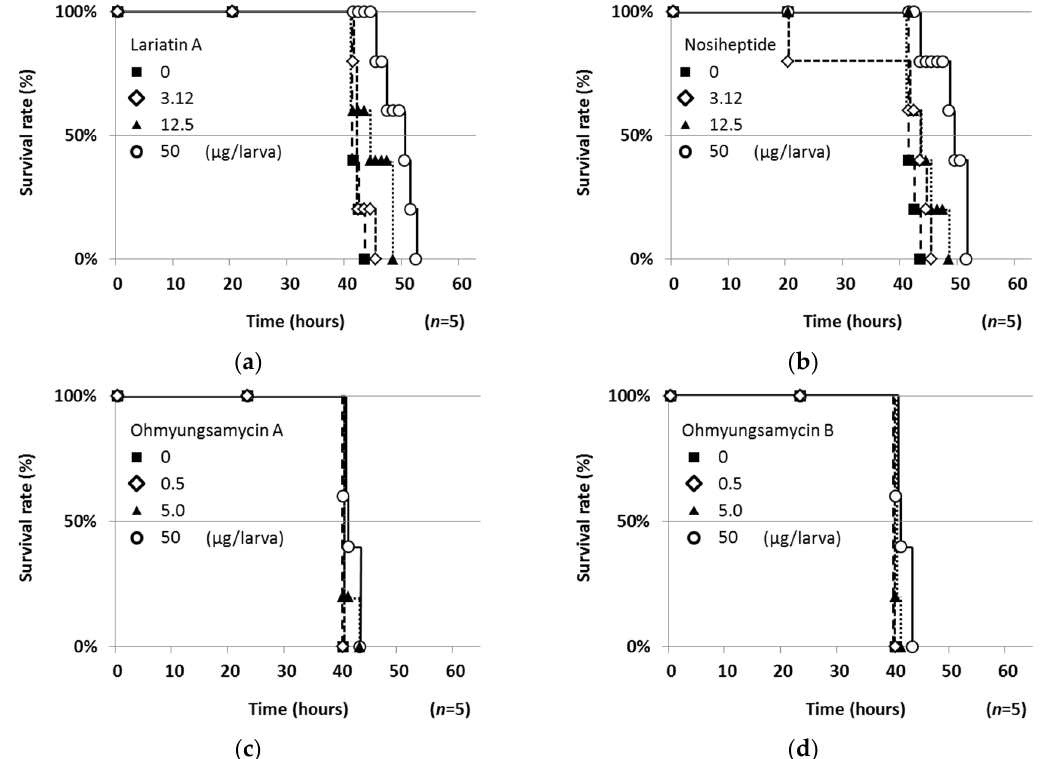
Figure 6. Therapeutic effects of microbial anti-NTM compounds in the silkworm infection assay with My. abscessus . ( a ) Lariatin A ( 1 ), ( b ) nosiheptide ( 2 ), ( c ) ohmyungsamycin A ( 3 ) and ( d ) ohmyungsamycin B ( 4 ). Experiments were performed twice to confirm reproducibility.